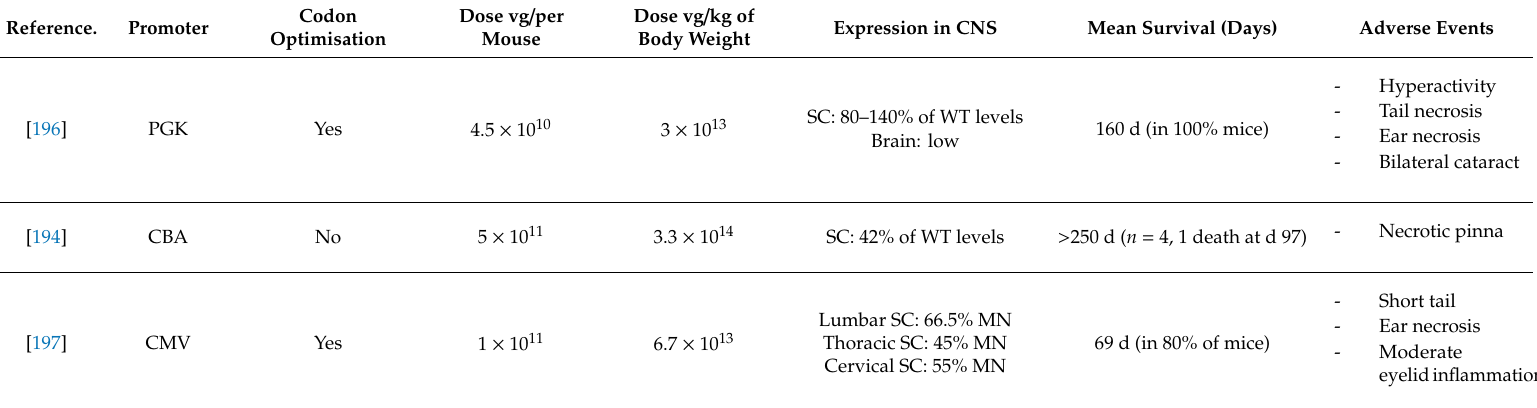
Table 2. Preclinical animal studies in mice models of